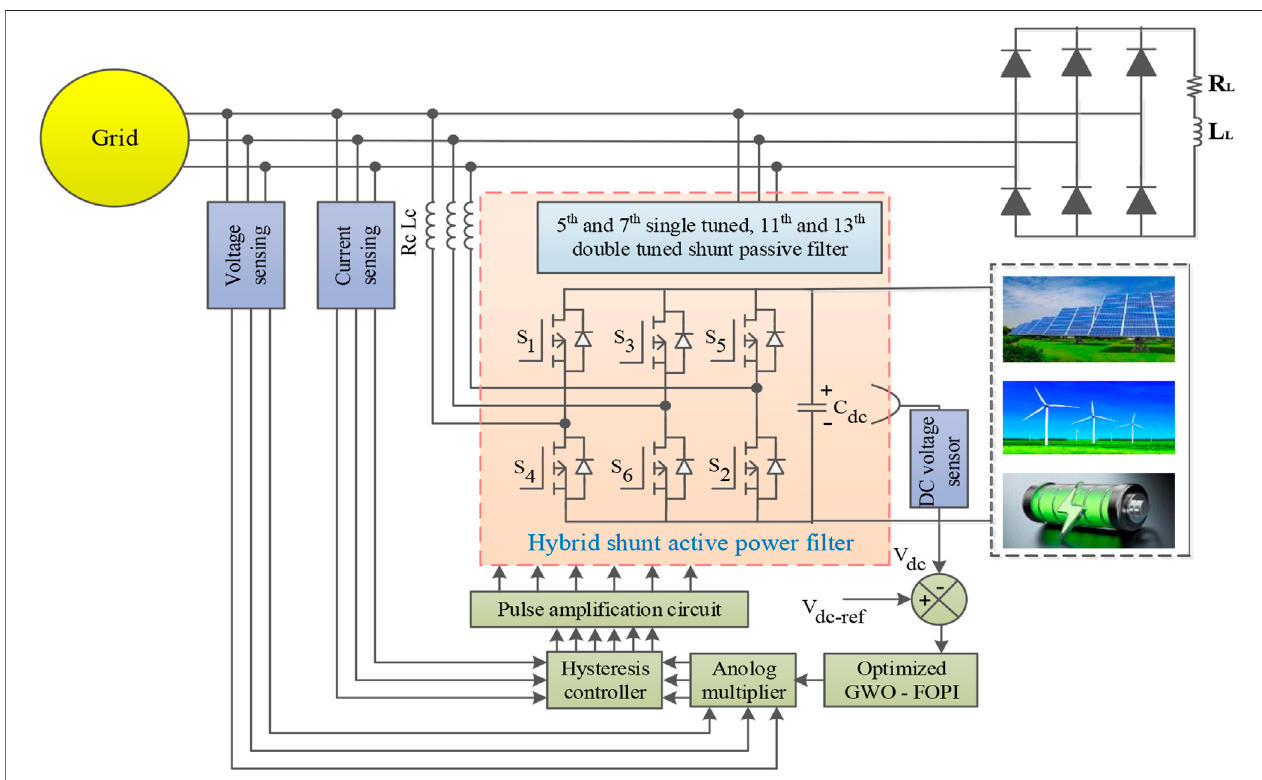
FIGURE 2 | Schematic diagram of RES-based HSHAPF.